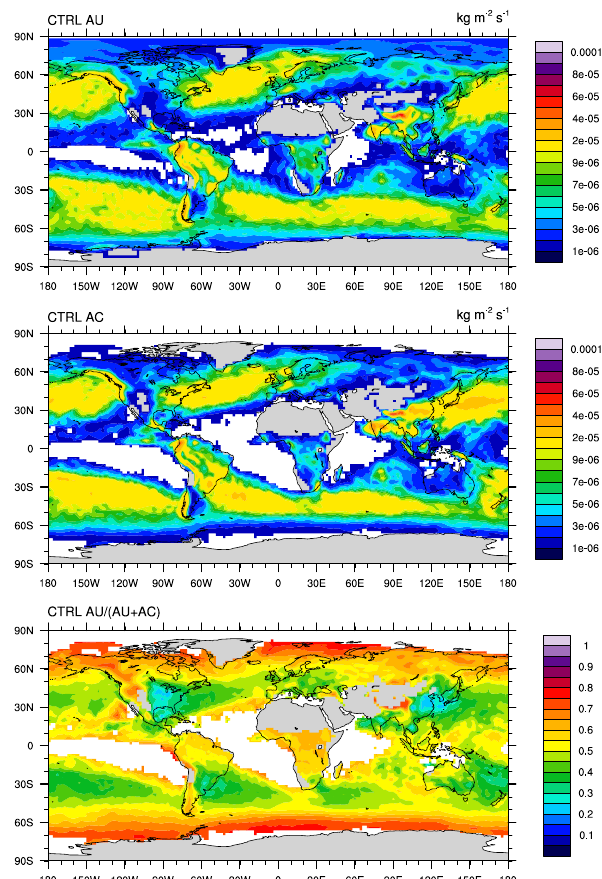
Figure 7. Mean vertically integrated autoconversion (AU) and ac- cretion rates (AC) of CTRL for the year 2000, such as the fraction of AU to the total collection rate (AU +